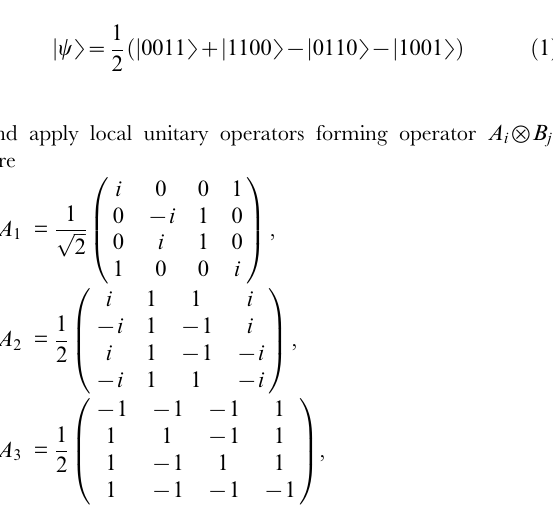
Table 2. Sets S ij – plus sign ( + ) indicates that the given element belongs to the set, minus ( 2 ) sign indicates that the element does not belong to the